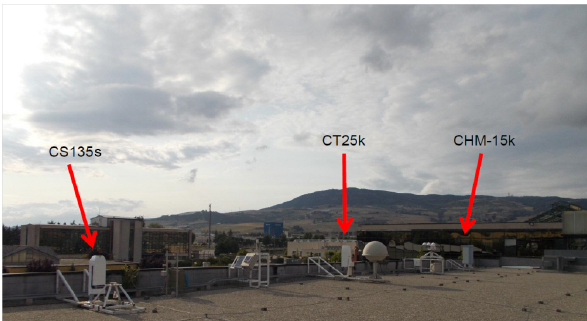
Figure 1. Ceilometer locations on CNR-IMAA Potenza observatory